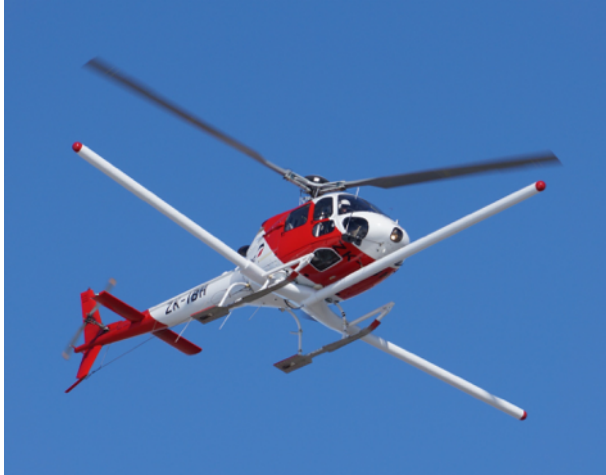
Figure 2. Helicopter in survey configuration. Radar antennas were mounted in the lateral booms, which measure 11.52m from tip to tip; the front boom was empty. The laser altimeter and dSLR camera were mounted to the right of the pilot’s seat using a pre-existing